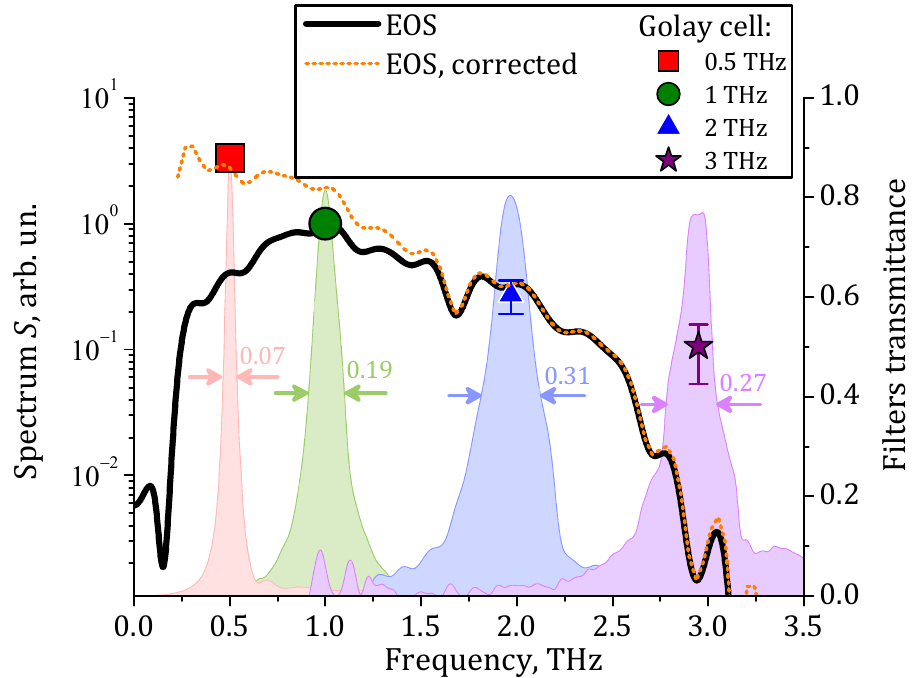
Figure 2. Spectrum of THz radiation obtained after integration of measured by the Golay cell with bandpass filters angular distributions of THz spectral intensity I ( θ ) (symbols, left axis) and spectrum measured by EOS (black curve, left axis). The orange dotted curve (left axis) is the spectrum calculated from the one measured by EOS (the black solid curve) using the EOS sensitivity from Appendix A, Equation (A11). The colored areas (right axis) show THz bandpass filters transmittance spectra. Arrows with numbers indicate their full width at half maximum ∆ ν in terahertz